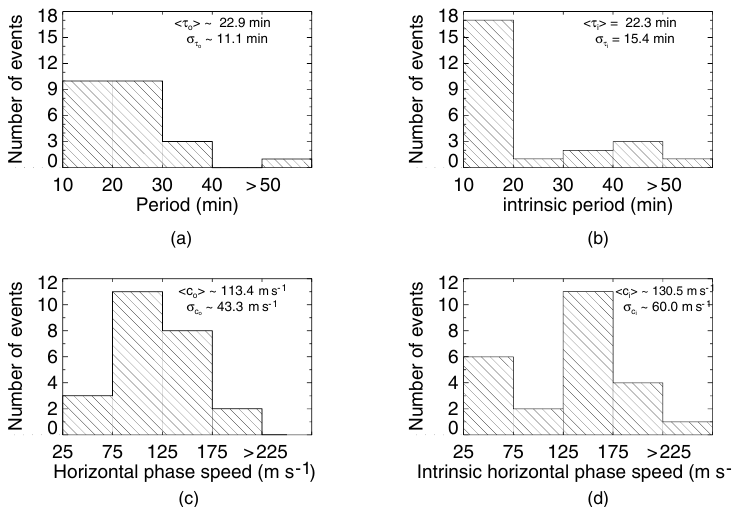
Figure 2. Histograms for the (a) observed periods, (b) intrinsic periods, (c) observed phase speeds and (d) intrinsic phase speeds. The number in the brackets represents the average and the standard deviation of the mean is represented by σ